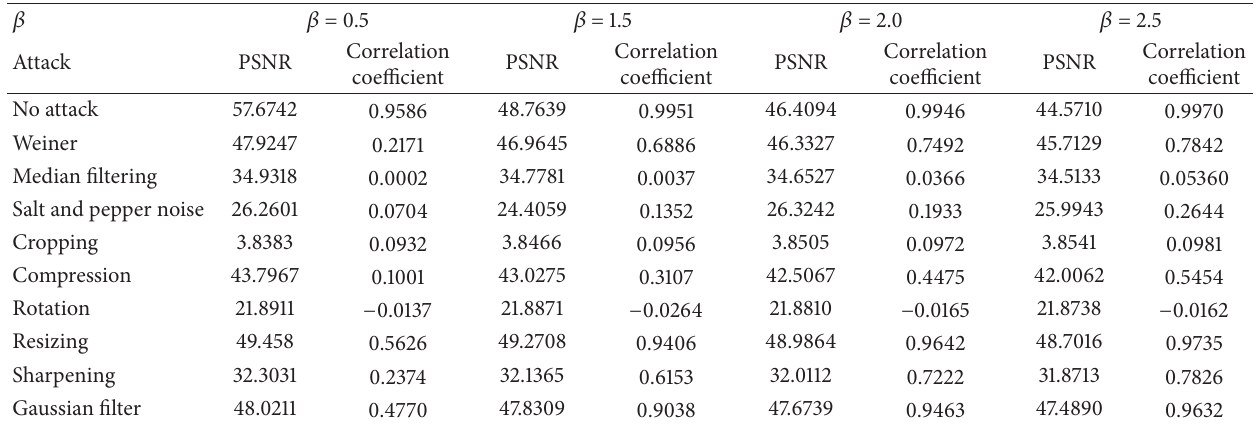
Table 3: Correlation coefficients of extracted watermarks